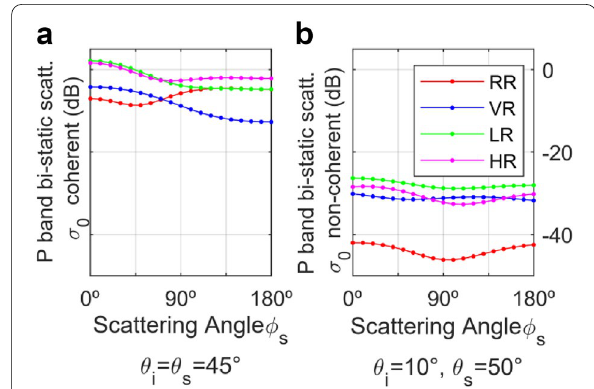
Fig. 10 Bistatic scattering of different polarizations at the P-band. In a is presented the coherent component, while the non-coherent scattering is presented in b